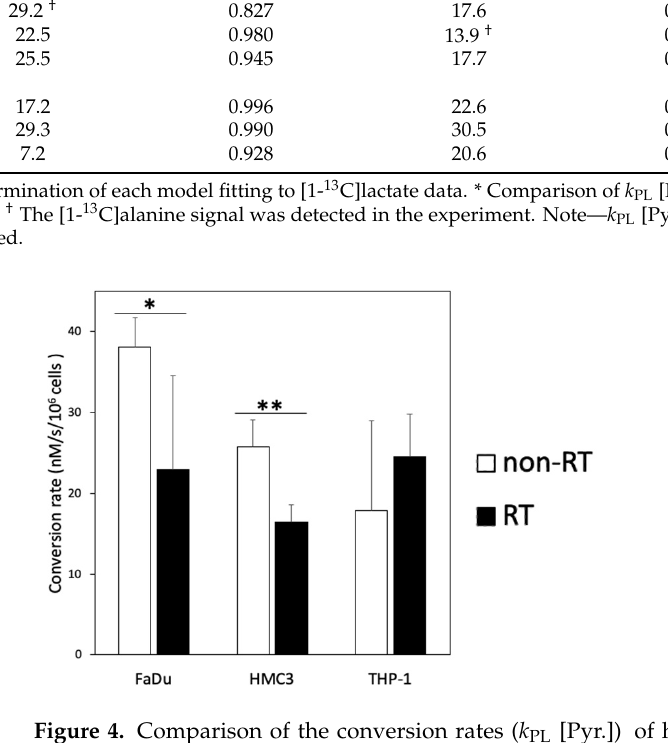
Figure 4. Comparison of the conversion rates ( k PL [Pyr.]) of hyperpolarized [1- 13 C]pyruvate to [1- 13 C]lactate between the non-irradiated (non-RT) and irradiated (RT) FaDu, HMC3, and THP-1 cells (* p < 0.05; ** p < 0.01). Note— k PL [Pyr.] unit: nM/s/10 6